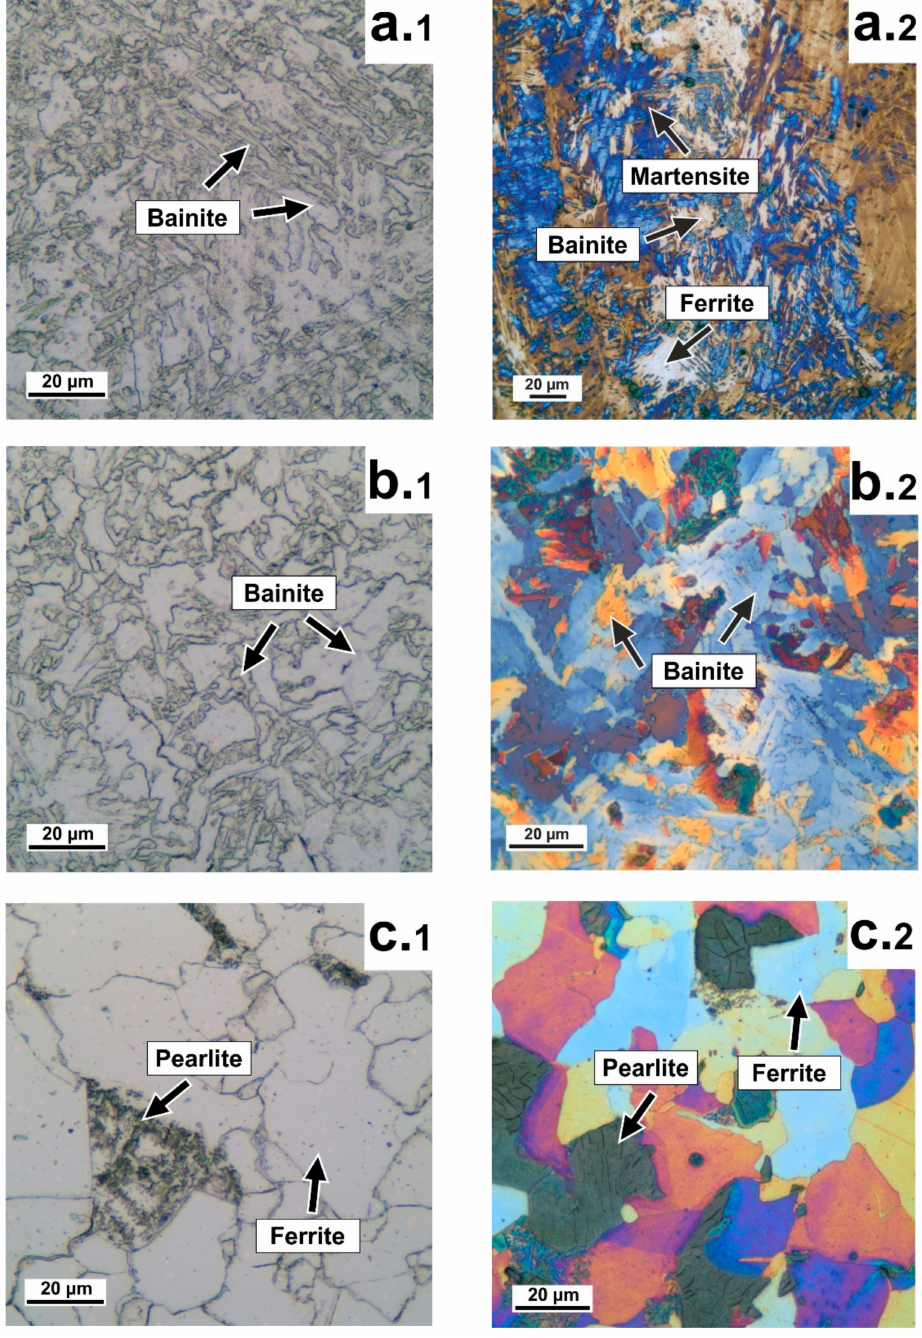
Figure 2. Microstructural observations using an optical microscope: ( a.1 – c.1 ) Nital etching; ( a.2 – c.2 ) Klemm etching; ( a ) Initial state after DLD; ( b ) Mode 1 (DLD +HT); ( c ) Mode 2 (DLD +